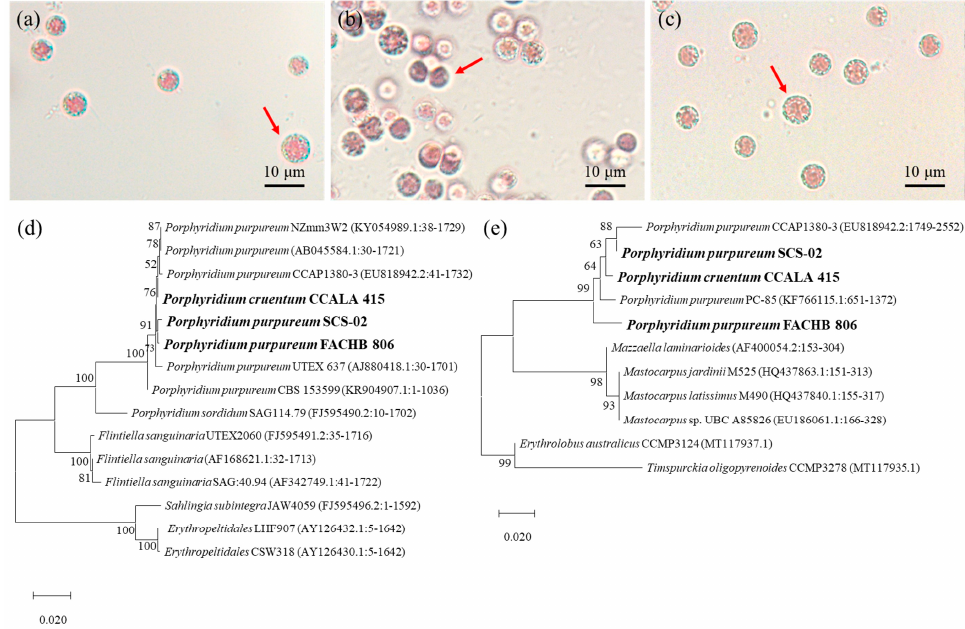
Figure 1. Cell morphology of P. cruentum CCALA-415 ( a ), P. purpureum SCS-02 ( b ) and P. purpureum FACHB-806 ( c ). Phylogenetic tree based on 18s rDNA gene sequence ( d ) and internal transcribed spacer regions ( e ) of the three strains of Porphyridium.